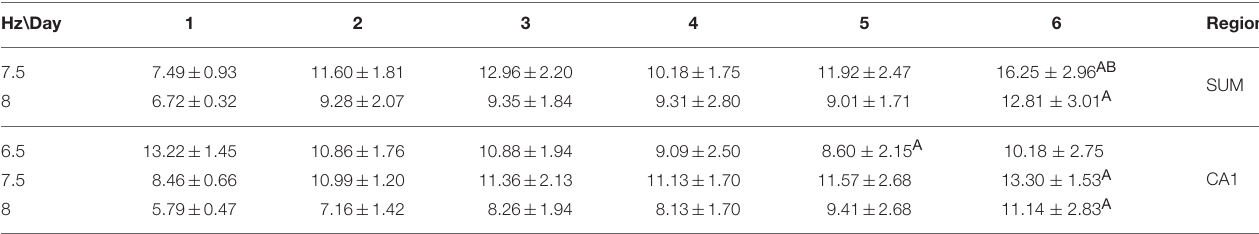
TABLE 2 | Comparison between training days of the relative power recorded during the searching for the platform in the Morris water maze task in the EXP group. Hz\Day 1 2 3